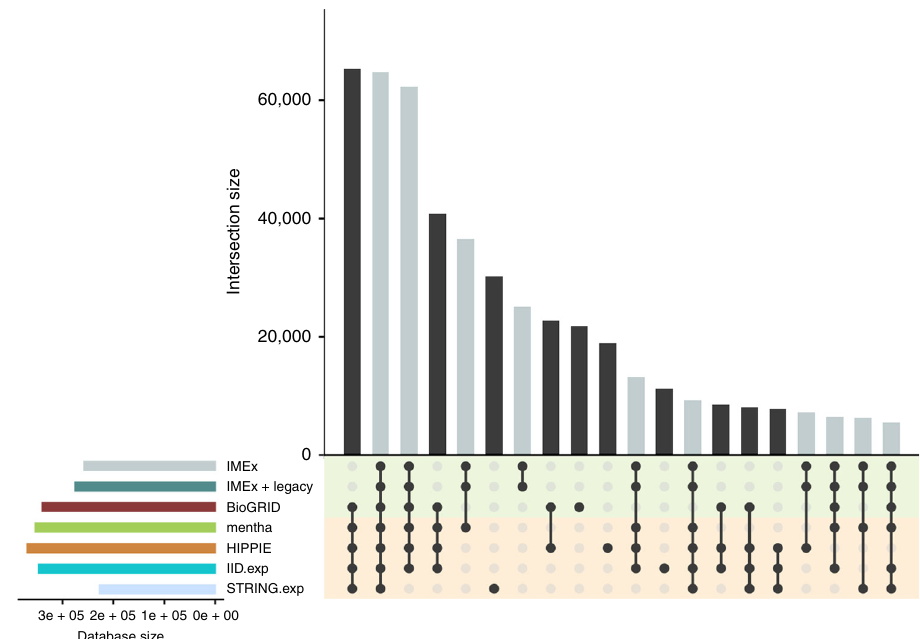
Fig. 1 Overlap between Unique human PPIs from different resources. The intersection plot shows several PPI resources as well as legacy data curated by IMEx partners. Individual resource sizes are displayed as horizontal bars on the lower left corner of the image. Intersection sizes are shown as individual bars, with those including IMEx data highlighted in grey. Speci fi c resources involved in each intersection are identi fi ed with connected solid black circles under the vertical bars, with unconnected circles representing pairs that are found exclusively in the corresponding database. Shading in the background of the circles helps differentiate between primary databases (green) and meta-databases (orange). Only the experimentally-derived content of the IID and STRING databases was used, excluding all predicted or text-mined interaction data. Only the 20 largest of all possible intersections are shown for clarity.